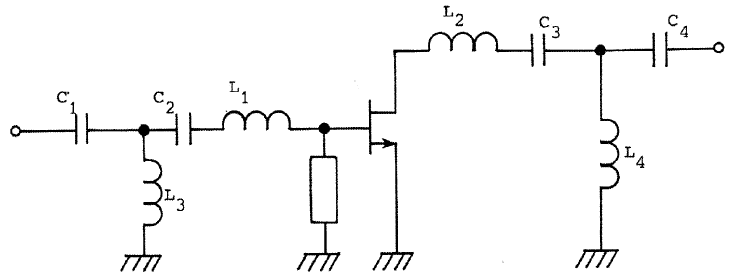
FIGURE 1 Amplifier circuit topology (device is 900 m m